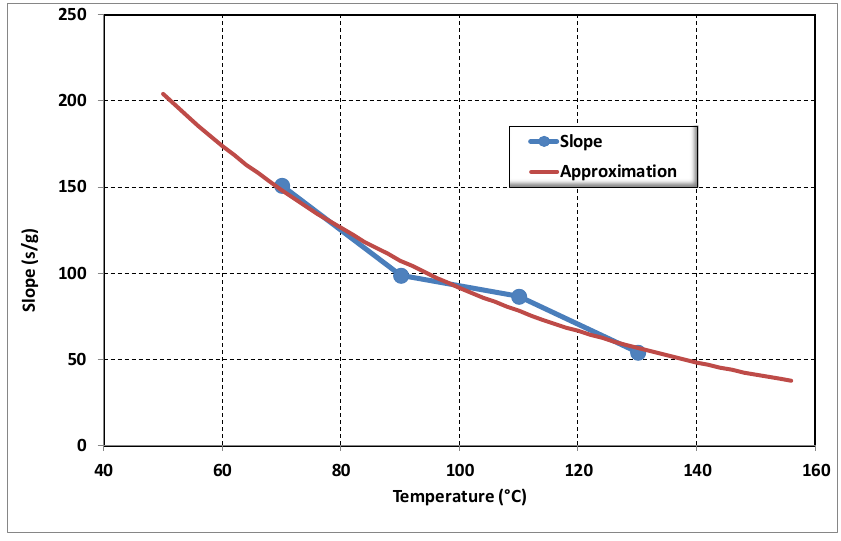
Figure 7. The approximation function of the slopes of Figures 6 and 8 as a function of temperature.